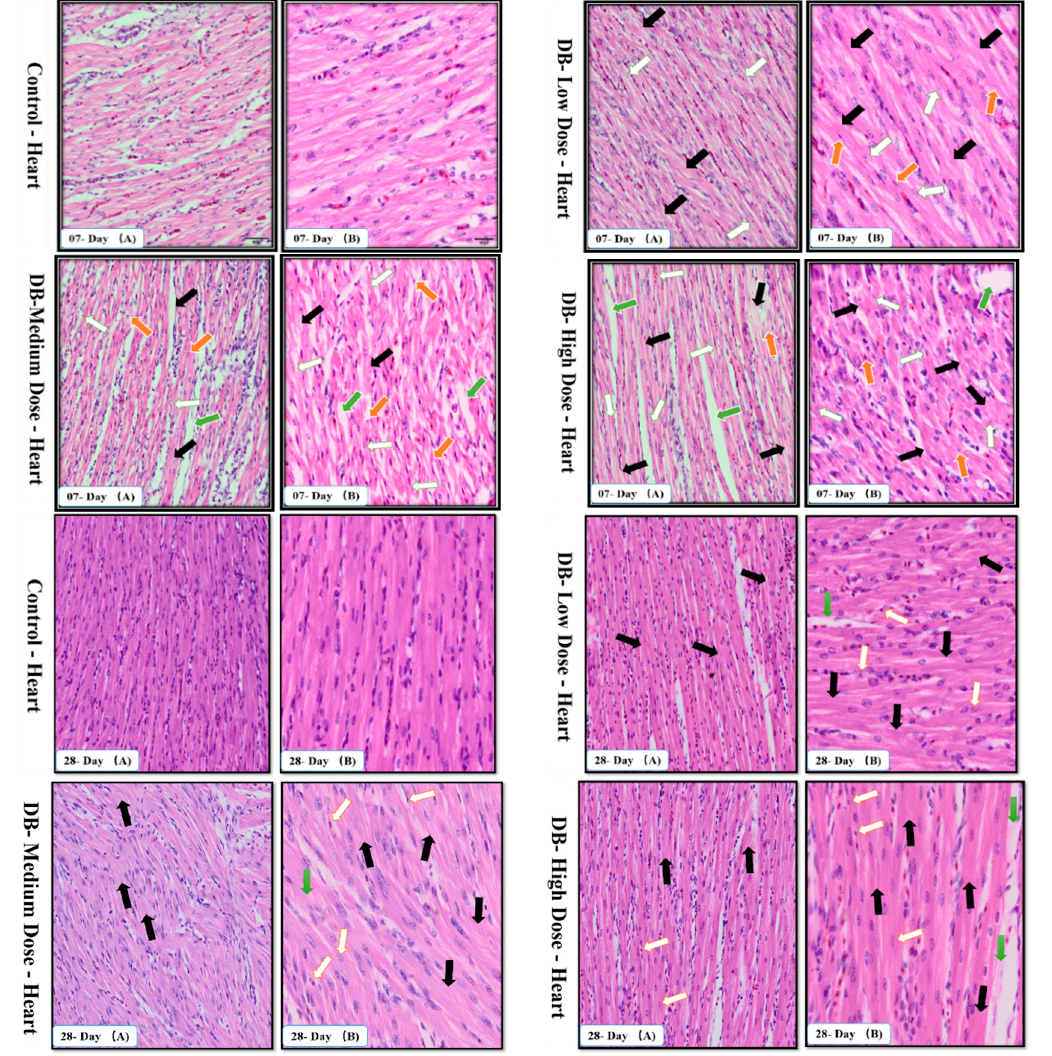
Figure 2. E ff ects of Denatonium benzoate supplementation on chicken heart histomorphology on days 07 and 28 ( A , B ). On day-07 necrosis (red arrow), apoptotic cells (white arrow), pyknotic cells (yellow arrow) and distortion of the morphological characteristics of the cells (green arrow) due to the toxic e ff ect of DB were seen. On day-28, karyolysis due to severe necrosis which caused autophagy (black arrow), apoptotic cells (white arrow) shrinkage of fibroblasts which led to condensation (green arrow) indicate the e ff ect of DB.